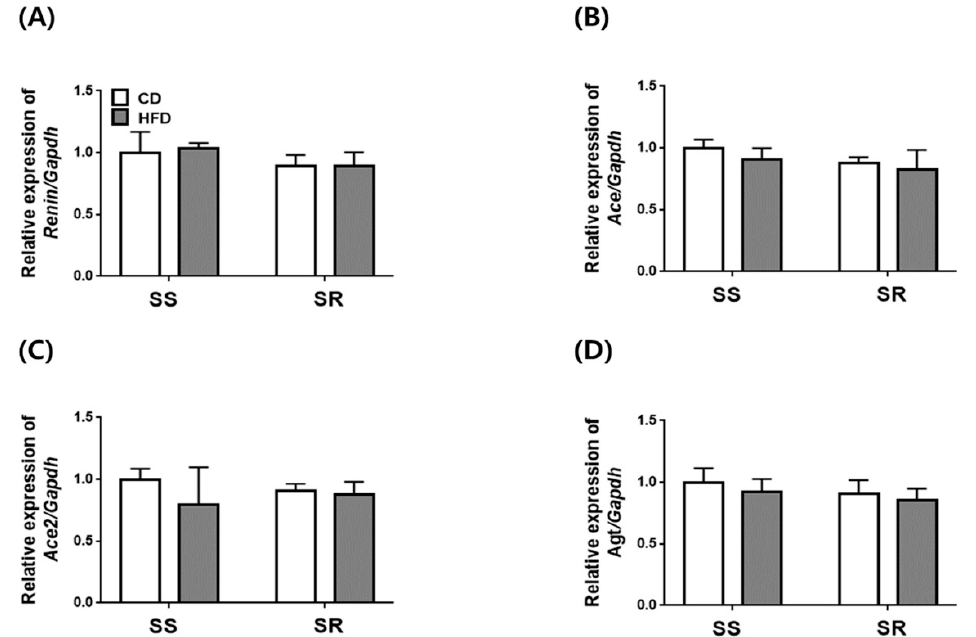
Figure 6. The effects of a high-fat diet on the expression of genes related to angiotensin II in kidneys from SS and SR rats. The mRNA expressions of angiotensin II-related genes such as Renin ( A ), Ace ( B ), Ace2 ( C ), Agt ( D ) were measured by RT-qPCR in the kidneys of SS and SR rats fed a CD or HFD for 12 weeks. Graph, mean ± SEM of 6 independent experiments. Two-way analysis of variance followed by Tukey’s post hoc multiple comparisons test.